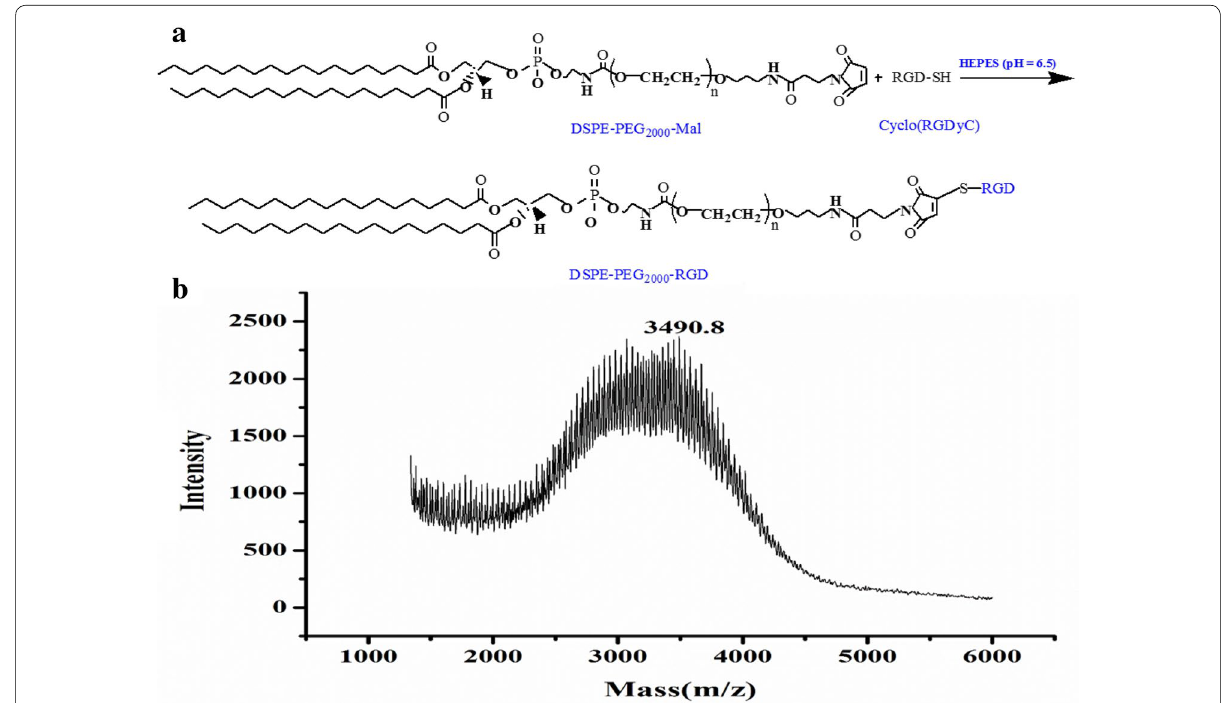
Fig. 2 Synthesis of RGD–PEG2000–DSPE. a scheme of the synthesis of RGD–PEG2000‑DSPE; b MALDI‑TOF mass spectra of the synthesized RGD– PEG2000–DSPE